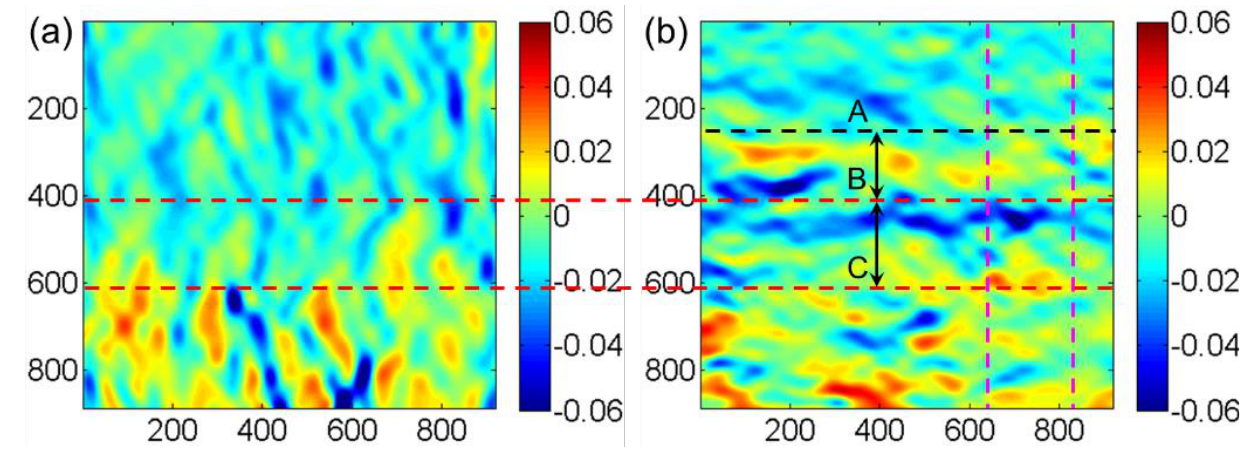
Figure 6. Strain distribution near the two-phase interface at room temperature: ( a ) [020] direction and ( b ) [200] direction.